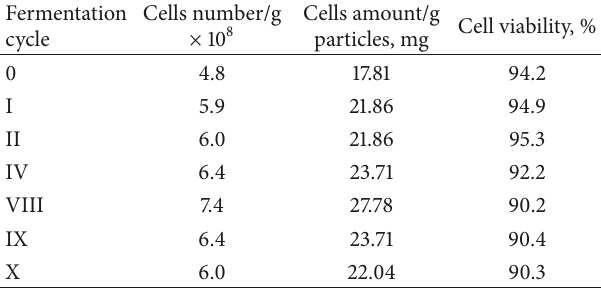
Table 7: Cell viability and cells amount in one gram of particles determined according to various repeated fermentation cycles for sample PD2.